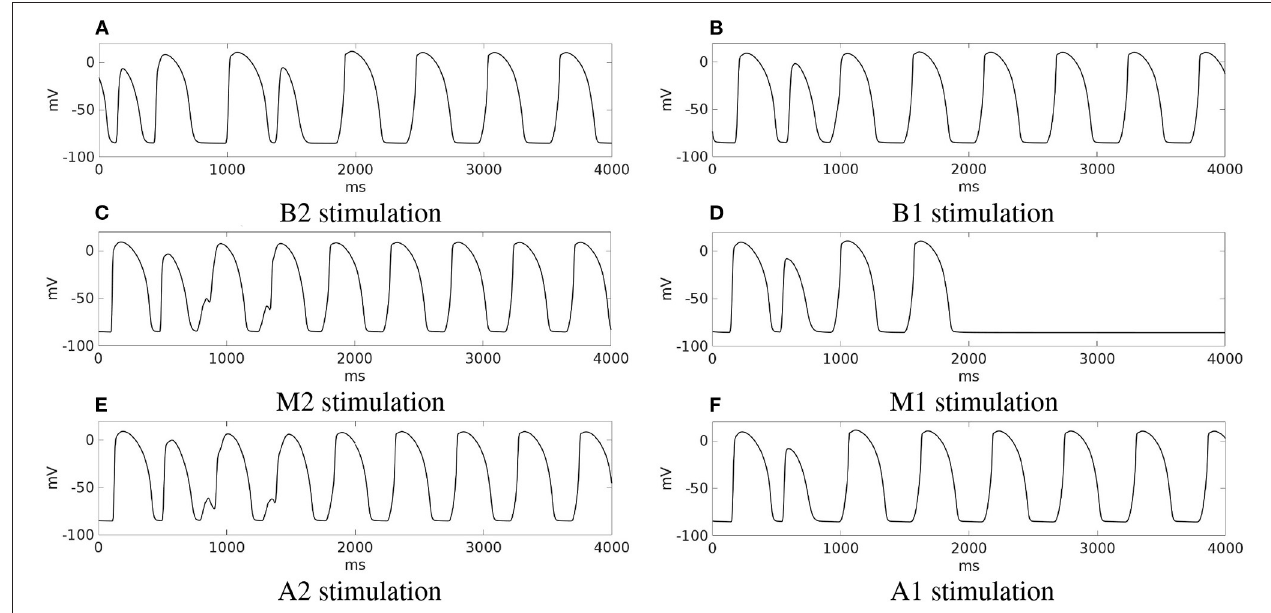
FIGURE 10 | Patient #1. (A–F) Transmembrane potential waveforms in the six stimulation cases, computed from an epicardial size located in the BZ, at the exit of the transmural isthmus.